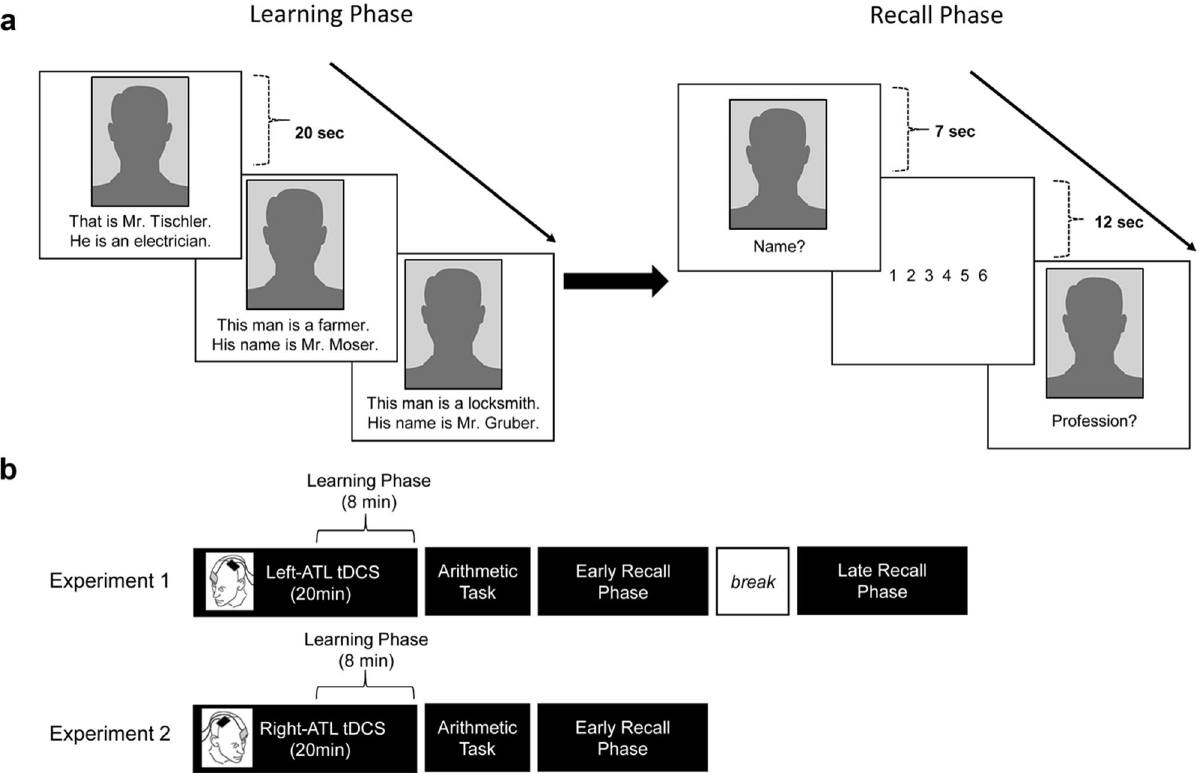
Figure 1. Experimental procedures ( a ) Task design. During the learning phase, the pictures and associated surname-profession pairs were presented twice for 20 s. In the recall phases, the pictures were randomly presented without the surname-profession pairs. Participants had to recall either the name or the profession assigned to the picture. A six-point confidence rating scale followed each picture. ( b ) Time course of the experiments. In Experiment 1, participants underwent three sessions of tDCS stimulation of the left ATL for 20 min. The learning phase coincided with the last 8 min of the stimulation. A one-minute arithmetic task followed the learning phase. Then the participants were asked to recall the surnames or professions immediately after the arithmetic task (early recall phase) and after a 30-min break (late recall phase). The procedure was similar for Experiment 2 except that the right ATL was stimulated, and only the early recall phase was implemented. The image of a human silhouette was adapted from Pixabay (https:// pixab ay. com/). tDCS = transcranial direct current stimulation, left-ATL = left anterior temporal lobe, right-ATL = right anterior temporal